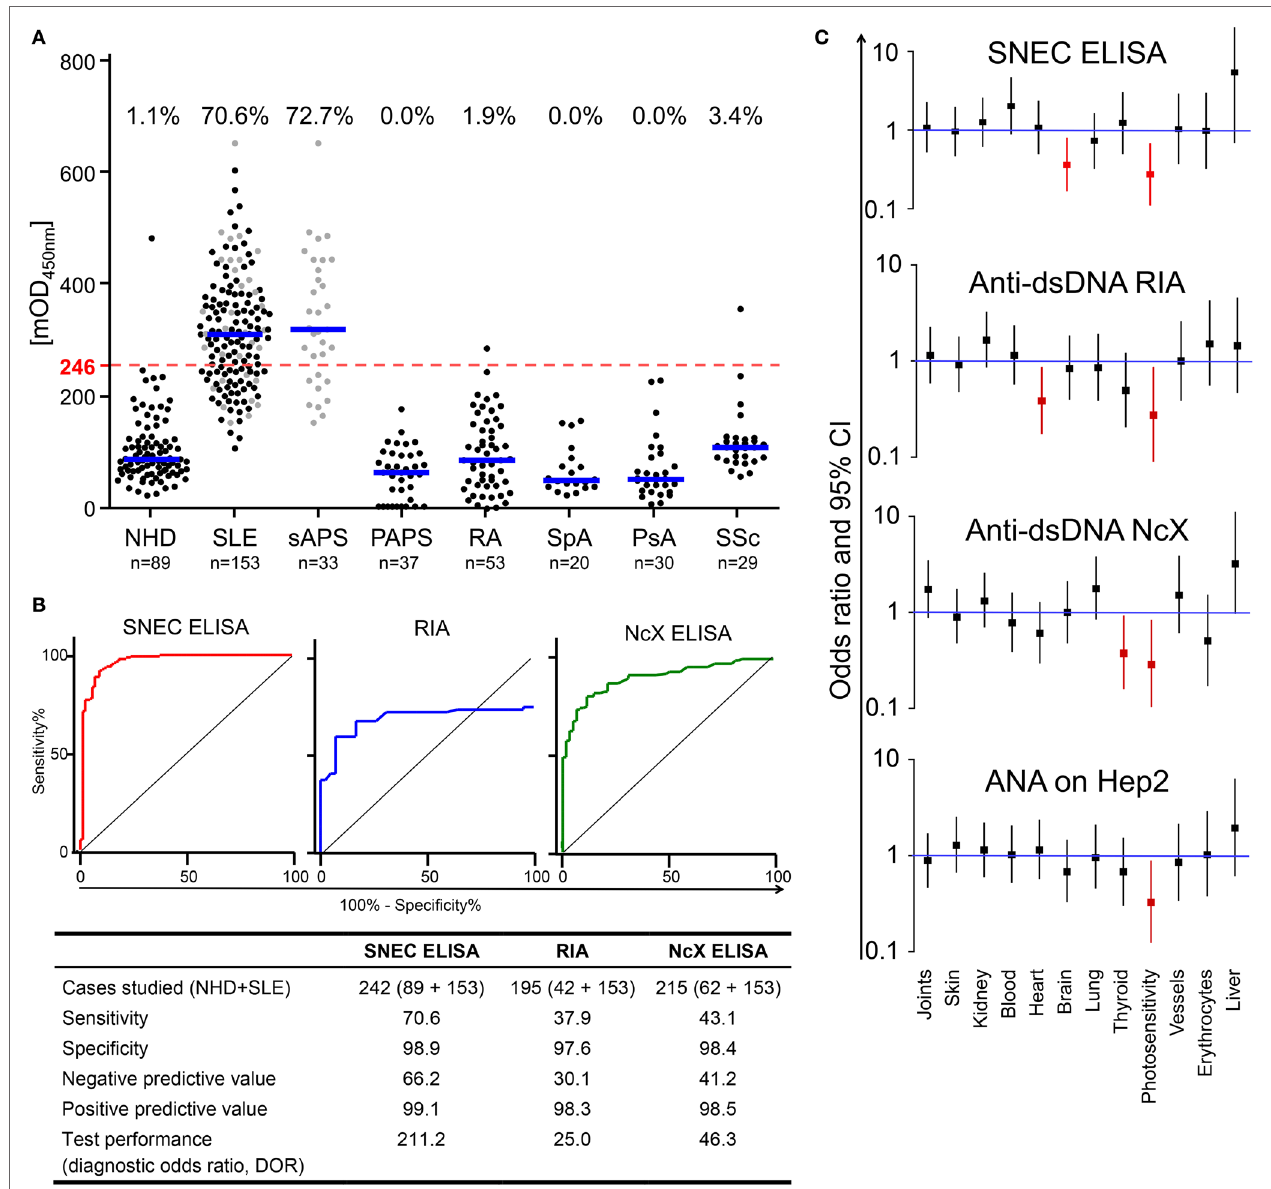
FigUre 2 | SLE-derived AAb are specifically and sensitively detected by secondary NEcrotic cell (SNEC) ELISA. (a) Reactivity of sera from normal healthy donors (NHD) and patients with SLE, secondary anti-phospholipid syndrome (sAPS, gray dots in the SLE cohort), primary anti-phospholipid syndrome (PAPS), spondyloarthropathy (SpA), psoriatic arthritis (PsA), and systemic sclerosis (SSc) against SNEC were assessed by ELISA. Using receiver operating characteristic (ROC) analysis, the cut-off for positive values was calculated at 246 mean optical density (dashed red line). Frequencies of SNEC positivity are displayed above the respective cohort in percent (%). (B) The overall test performance of the SNEC ELISA (left), radioimmunoassay (RIA) dsDNA Farr assay (center), and anti-dsDNA- NcX-ELISA (right) was evaluated employing ROC analysis. The respective diagnostic parameters (specificity, sensitivity, negative predictive value, positive predictive value, and diagnostic odds ratio) were calculated and are displayed below. (c) Organ involvement was analyzed by comparison of odds ratios for SNEC ELISA, anti-dsDNA RIA, anti-dsDNA-NcX ELISA, and anti-nuclear antigen on HEp-2 titers. The depicted odd ratios are within the 95% confidence